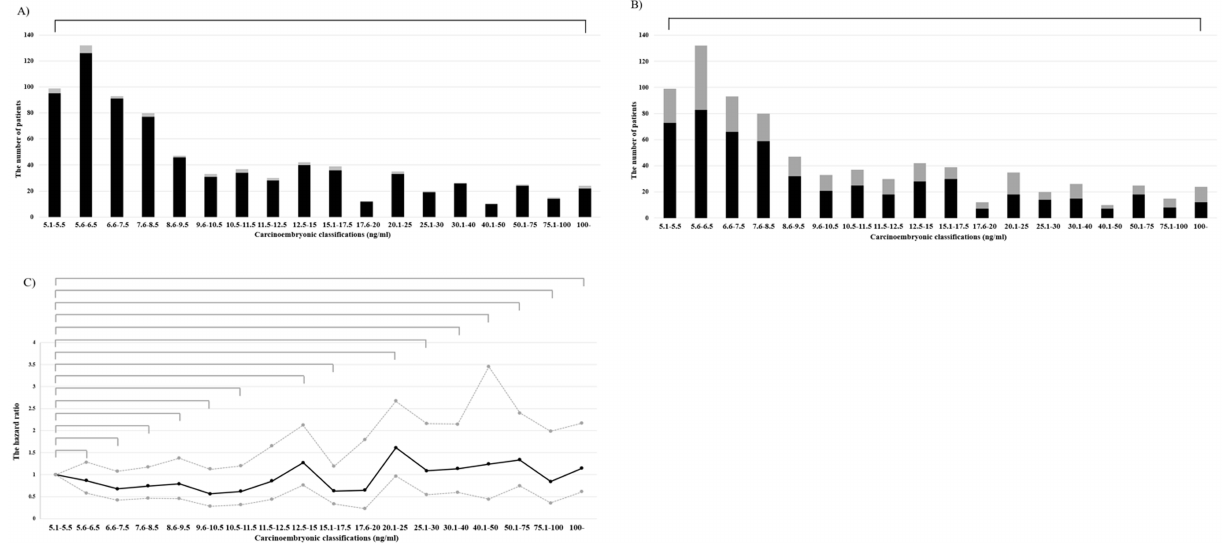
Figure 3. Surgical procedures and outcomes. ( A ) Distribution of lobectomy. Black: lobectomy; gray: more than lobectomy. ( B ) Distribution of lymph node dissection. Black: lobe-specific lymph node dissection; gray: systemic lymph node dissection. ( C) Black line: Hazard ratio; gray line: 95% confidential